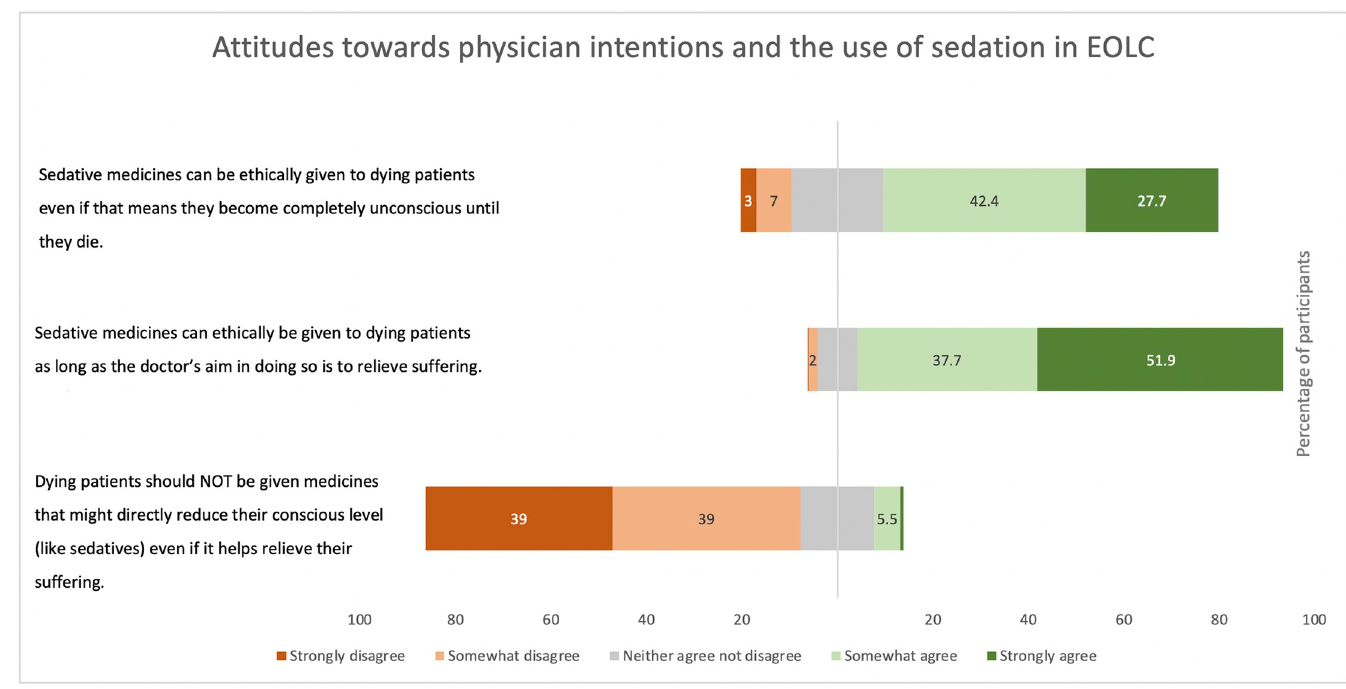
Fig 1. Attitudes towards physician intentions and the use of sedation (n =